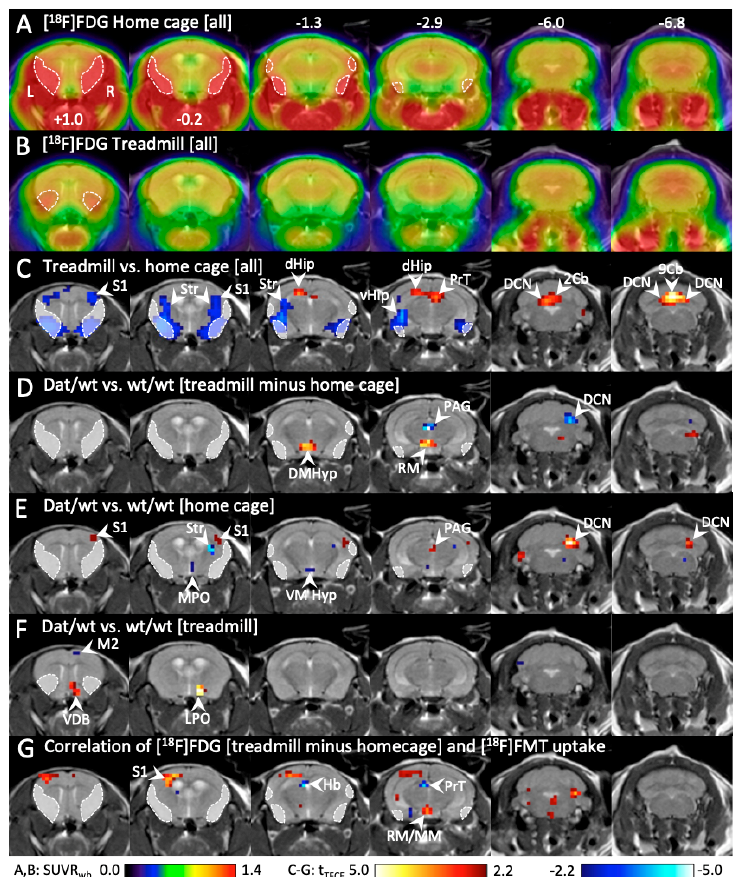
Figure 5. Change in cerebral [ 18 F]FDG uptake during running and home cage stay in Dnmt3a2 / 3L Dat / wt mice compared to control littermates.( A ) Mean [ 18 F]FDG uptake in the homecage ( n = 14). Because the mice groomed and gnawed, head muscles were active, causing radioactivity spillover into the brain (sketched areas). ( B ) Mean [ 18 F]FDG uptake during running on the treadmill ( n = 14). Head muscles were relaxed, only some spillover (sketched areas) from the Harderian glands is visible. ( C ) Significant di ff erences ( p < 0.05, corrected for multiple testing) between [ 18 F]FDG uptake during home cage and treadmill running across all animals. Red voxels: significantly higher [ 18 F]FDG uptake during running. Blue voxels: significantly higher [ 18 F]FDG uptake during home cages stay. ( D ) Comparison ( p < 0.05, corrected for multiple testing) of [ 18 F]FDG di ff erence images (“treadmill minus home cage”) between Dnmt3a2 / 3L Dat / wt mice and controls ( n = 7 each). Red voxels: significantly higher di ff erence between running and home cage in Dnmt3a2 / 3L Dat / wt mice. Blue voxels: significantly higher di ff erence between running and home cage in controls. ( E ) Significant di ff erences ( p < 0.05, corrected for multiple testing) of [ 18 F]FDG uptake in the home cage between Dnmt3a2 / 3L Dat / wt mice and controls ( n = 7 each). Red voxels: significantly higher [ 18 F]FDG uptake in Dnmt3a2 / 3L Dat / wt mice. Blue voxels: significantly higher [ 18 F]FDG uptake in control mice.( F ) Significant di ff erences of [ 18 F]FDG uptake during treadmill running between Dnmt3a2 / 3L Dat / wt mice and controls ( n = 7 each).( G ) Correlation ( p < 0.05, corrected for multiple testing with TFCE) between [ 18 F]FDG di ff erence images (“treadmill minus home cage”) and [ 18 F]FMT images with all animals pooled ( n = 12). Red voxels: positive correlation between [ 18 F]FMT uptake and [ 18 F]FDG di ff erence images. Blue voxels: negative correlation.Abbreviations: 2Cb, 9Cb: lobule 2 and 9 of the cerebellar vermis, AHyp: anterior hypothalamus, DCN: deep cerebellar nuclei, dHip: dorsal hippocampus, DMHyp: dorsomedial hypothalamus, Hb: habenula, LPO: lateral preoptic nucleus; M2: secondary motor cortex; MM: medial mammillary nucleus, MPO: medial preoptic nucleus; PAG: periaqueductal gray, PFl: paraflocculus, PrT: pretectum, RM: retromammillary nucleus, S1: primary sensory cortex, Sim: simple lobule of the cerebellum, Str: striatum, VDB: ventral diagonal band of Broca, vHip: ventral hippocampus, VMHyp: ventromedial hypothalamus; VTh: ventral